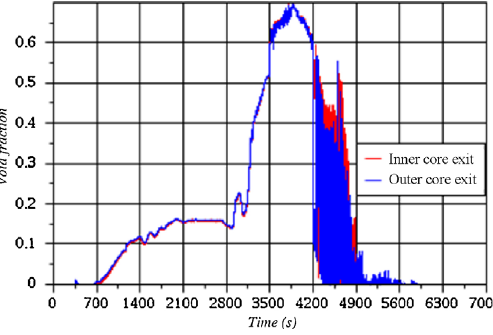
Fig. 21. Water level in the vessel. Grey area represents core zone.